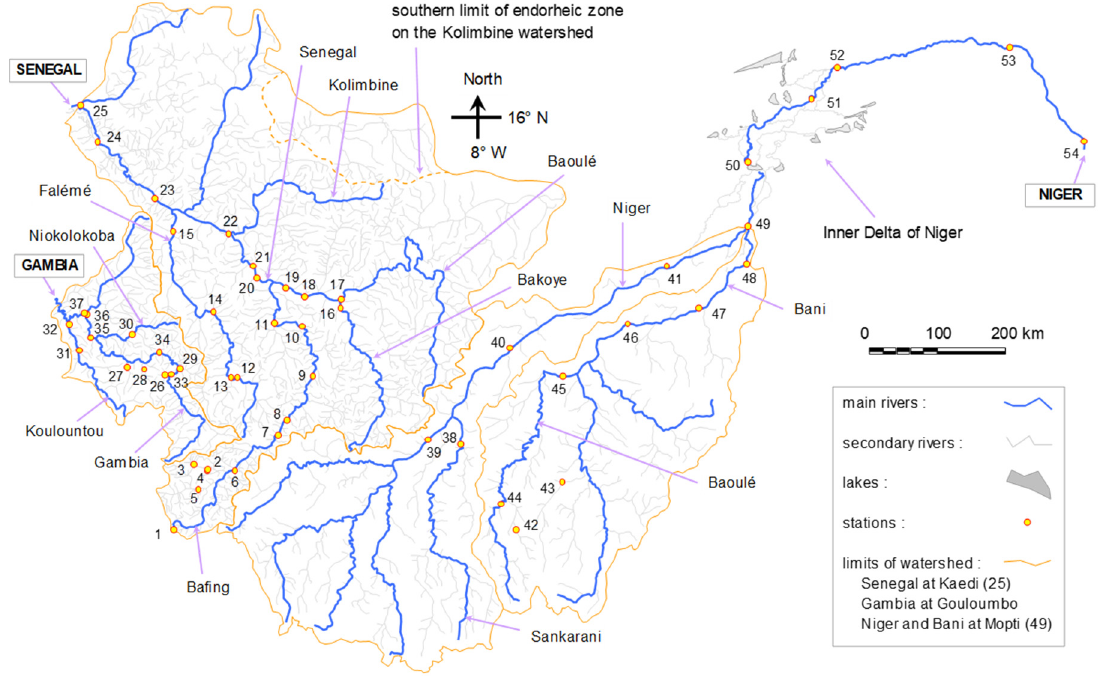
Figure 1. Hydrographic networks of the Senegal River upstream of Kaédi, Gambia upstream of Gouloumbo and Niger upstream of Ansongo, based on the maps of [40] for Senegal, [41] for Niger and [42] for Gambia. Water 2020 , 12 , x FOR PEER REVIEW